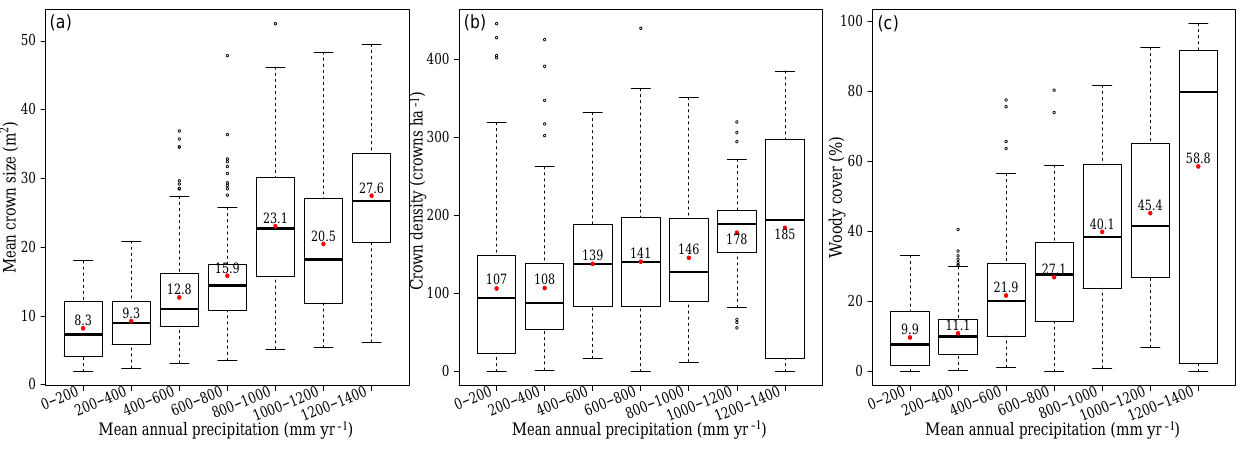
Figure 6. Boxplots of estimates of crown size, crown density, and woody cover along a rainfall gradient. Red points denote the means. Between the driest (<200mmyr − 1 ) and wettest (1200–1400mmyr − 1 ) categories, mean estimates of crown size, crown density, and woody cover increased by 233, 73, and 491% respectively.